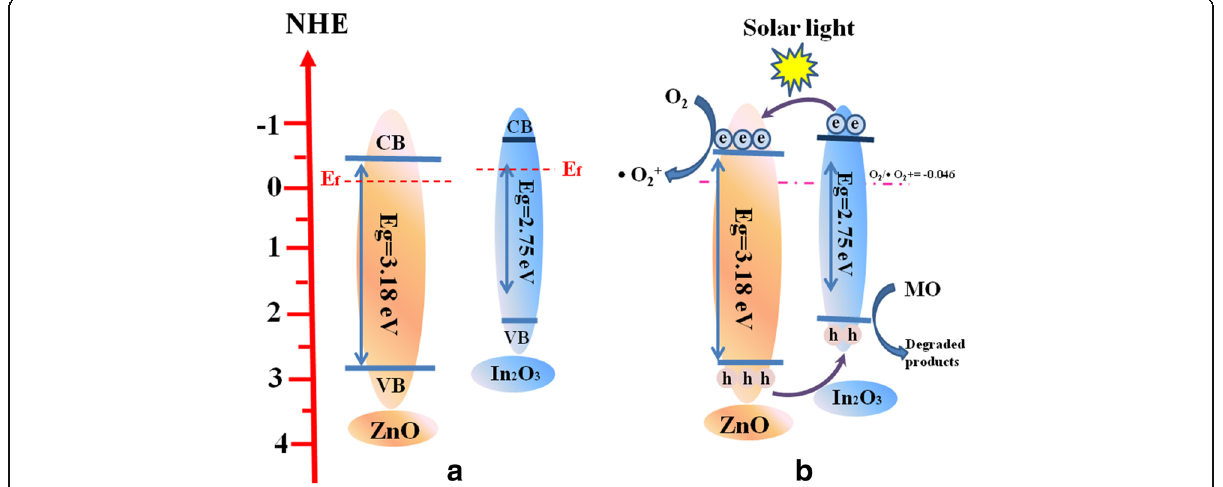
Fig. 10 Schematic diagram of the energy alignment ( a ) and charge transfer in the ZnO/In 2 O 3 composites under solar light irradiation ( b